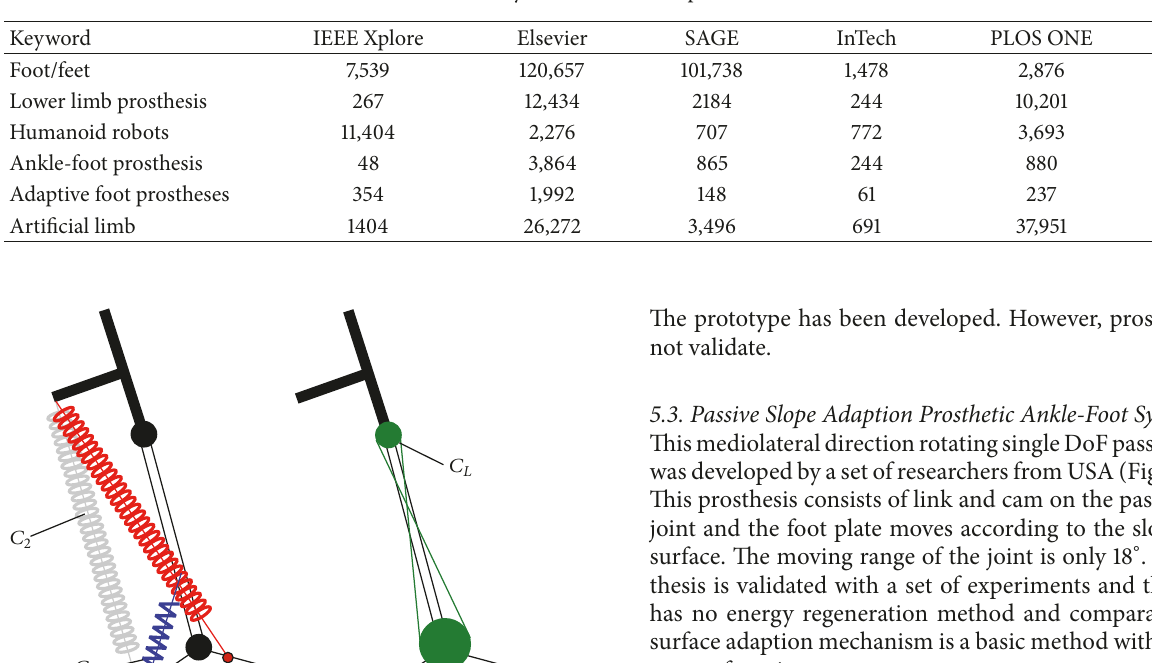
Table 7: Results of keyword search in respective academic databases.